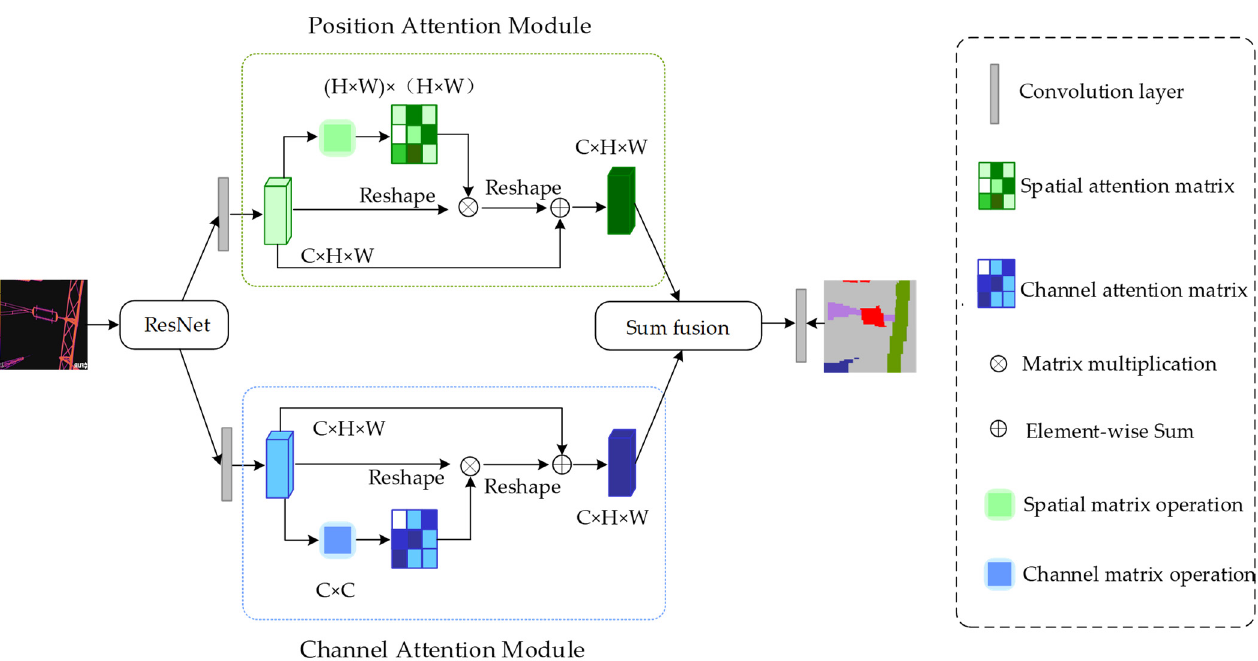
Figure 5. DANet module structure diagram.